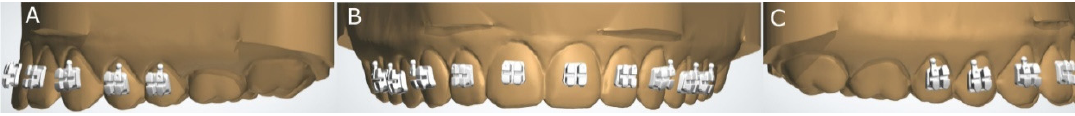
Figure 2. ( A ) Lateral left, ( B ) frontal, and ( C ) lateral right view of the orthodontic template digitally planned on the exper- imental anatomically based models. Subsequently, the orthodontic templates were manufactured using a three-dimen- sional impression technique (ProJet ® 6000. 3D Systems©, Rock Hill, SC, USA) in an acrylic resin (Ortho IBT, NextDent, Soesterberg, The Netherlands) that was polymerized for 10 min, following the manufacturer’s recommendations (Figure 3A–C). Figure 3. ( A ) Lateral left, ( B ) frontal, and ( C ) lateral right view of the fixed buccal multibracket appliances with the bonding trays on the anatomically based acrylic resin models. Finally, the fixed buccal multibracket appliances (Clarity™ Advanced, 3M Corp) were bonded on both the maxilla (from tooth 1.5 to 2.5) and mandible (from tooth 3.5 to 4.5) experimental models in the center of the buccal surface of the clinical crown with the photo-polymerized composite resin cement incorporated into the mesh of the brackets (APC™ FlashFree Adhesive, 3M Corp.), and without etching, resin adhesive application or additional photo-polymerized composite resin cement application. Then, all experi- mental anatomically based acrylic resin models were submitted to a digital impression using an intraoral scan (Trios, 3Shape, Copenhagen, Denmark) by means of 3D in-motion video imaging technology to obtain an accurate standard tessellation language (STL) dig- ital file. The image capturing procedure was performed, following the manufacturer’s rec- ommendations, by scanning the occlusal plane first, followed by the buccal and palatal surfaces. 2.3. Alignment Procedure Afterwards, the STL digital files were imported to a reverse engineering morphomet- ric software (3D Geomagic Capture Wrap, 3D Systems©, Rock Hill, SC, USA) and the teeth were individually segmented to allow for the accuracy alignment procedure between the